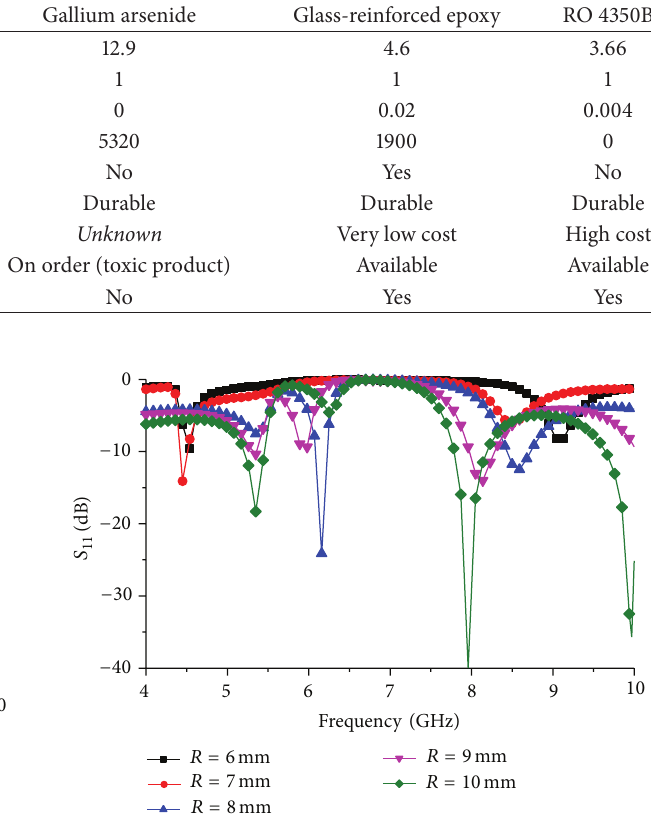
Figure 6: 𝑆 11 response for the change in dielectric constant.